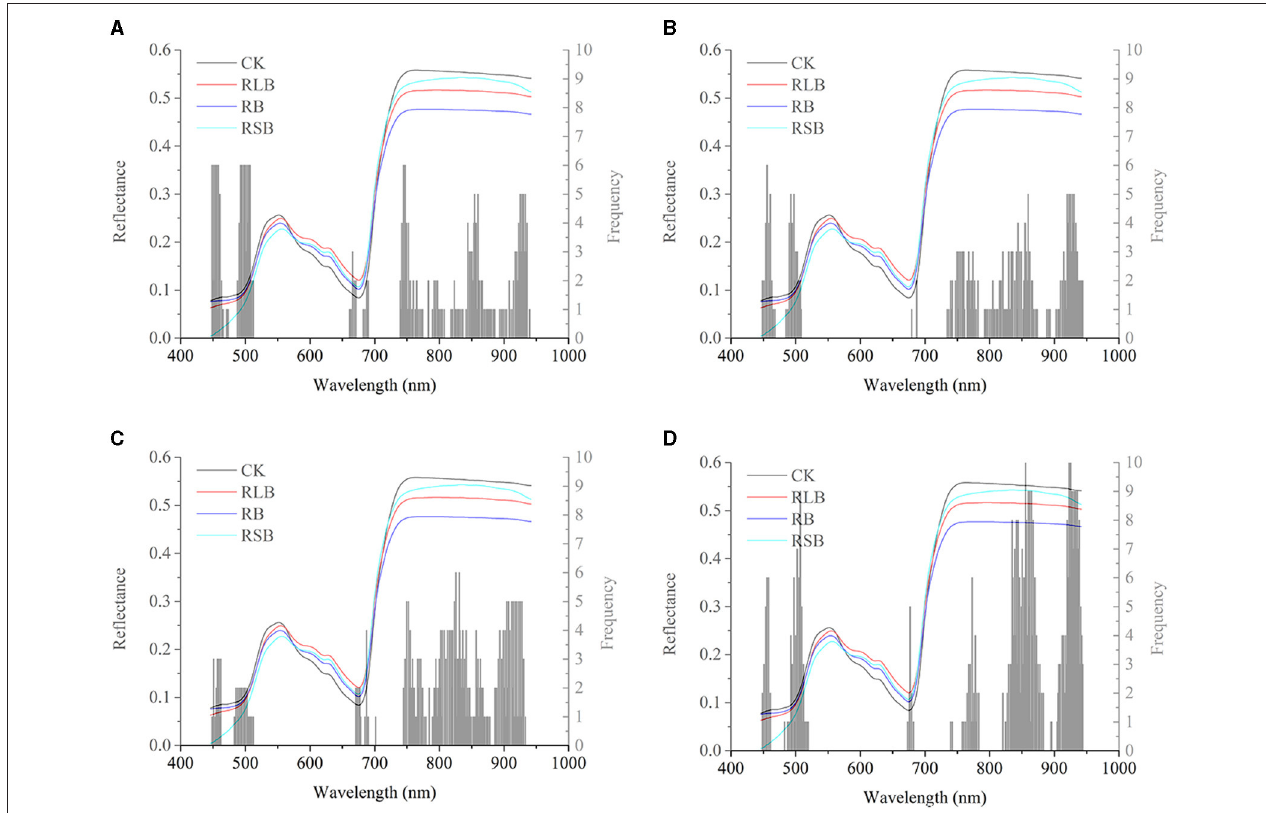
FIGURE 6 | Saliency map before transfer learning regarding the rice variety 01 (Zhongzheyou1). (A–D) represent the key wavelength ranges captured by CNN to correctly classify rice diseases with classes 0 (healthy samples, CK), 1 (rice leaf blight, RLB), 2 (rice blast, RB), and 3 (rice sheath blight, RSB), respectively.